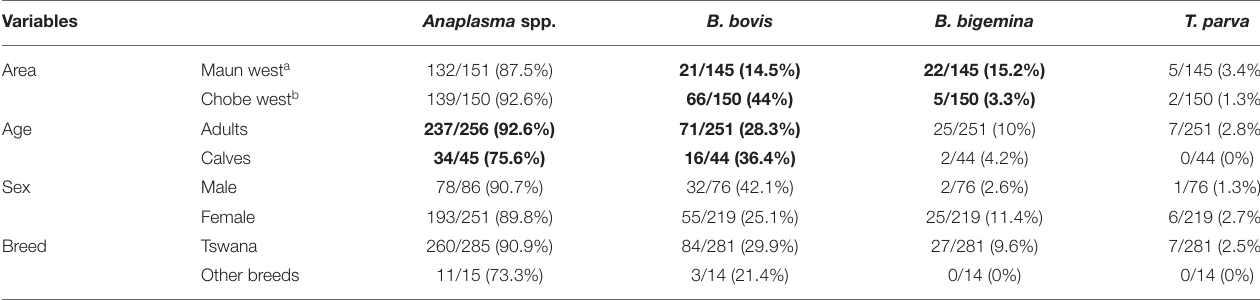
TABLE 2 | A comparison of selected TBD pathogens seroprevalence (%) per area, age, sex, and breed at wildlife-livestock interface areas in northern Botswana (Maun west and Chobe west).